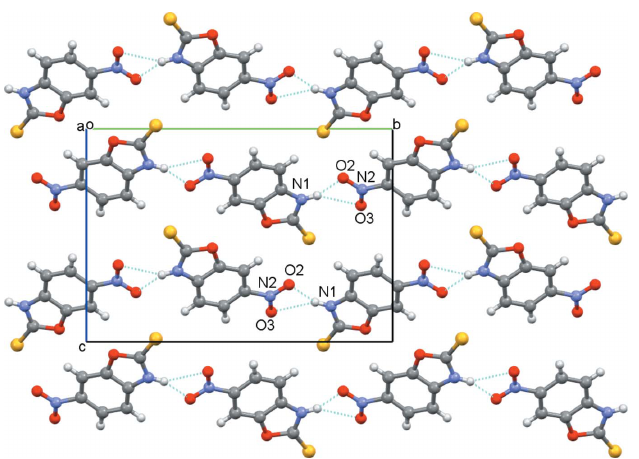
Figure 3 Crystal packing for the title compound showing molecules linked by hydrogen bonds (dashed blue lines) and (cid:2) – (cid:2) interactions (green lines).